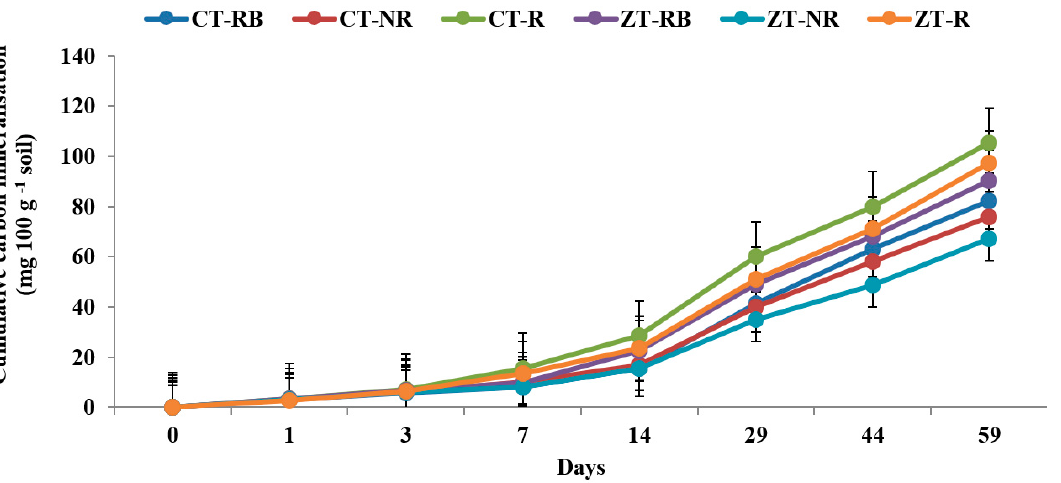
Figure 6. Cumulative carbon mineralization (mg 100 g − 1 soil) from micro-aggregate in 0–5 cm depths as affected by 18 years of tillage and residue management in a rice–wheat cropping system in an Inceptisol at 27 °C. ZT = zero tillage; CT = conventional tillage; NR = no residue; RB = residue burn- ing; R = residue retention. Error bars identify LSD ( p ≤ 0.05) of different treatments.